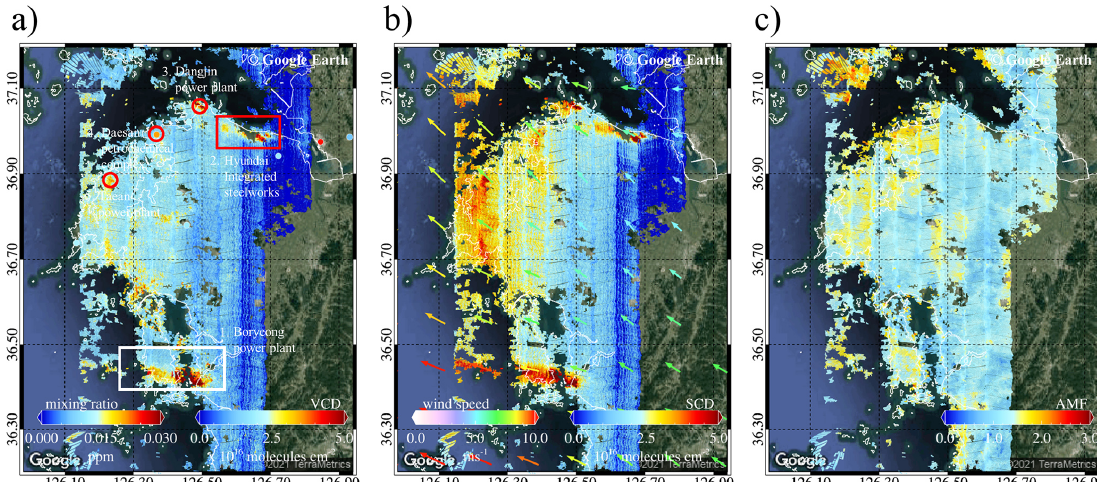
Figure 6. (a) Tropospheric NO 2 VCD and (b) NO 2 SCD retrieved from GeoTASO and (c) NO 2 AMF at native resolution (250m) calculated using VLIDORT over Anmyeon in South Korea on 5 June 2016. The colored arrows indicate wind speed and wind direction at 850hPa from the Unified Model (UM) simulations. The red circles and rectangle in (a) represent the major NO 2 emission sources, such as steelworks and power plants (background RGB image is from Google Earth; https://www.google.com/maps/, last access: 19 January 2023).